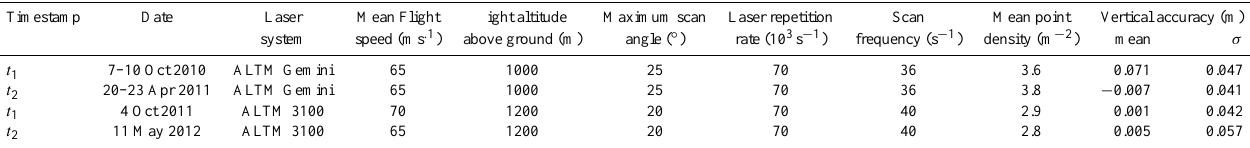
Table 2. Overview of the ALS flight campaigns investigated in this study. The vertical accuracy is obtained from differences between ALS surface elevations and elevations of a known reference surface. The vertical accuracy is shown in terms of a mean offset (mean) and the standard deviation ( σ